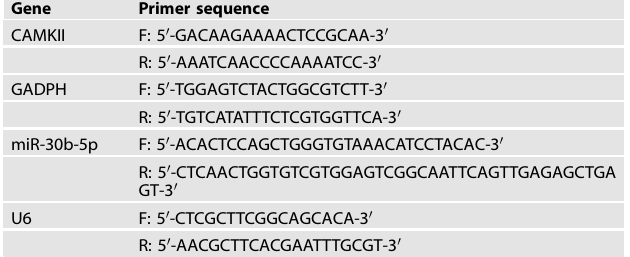
Table 1. Primer sequence of